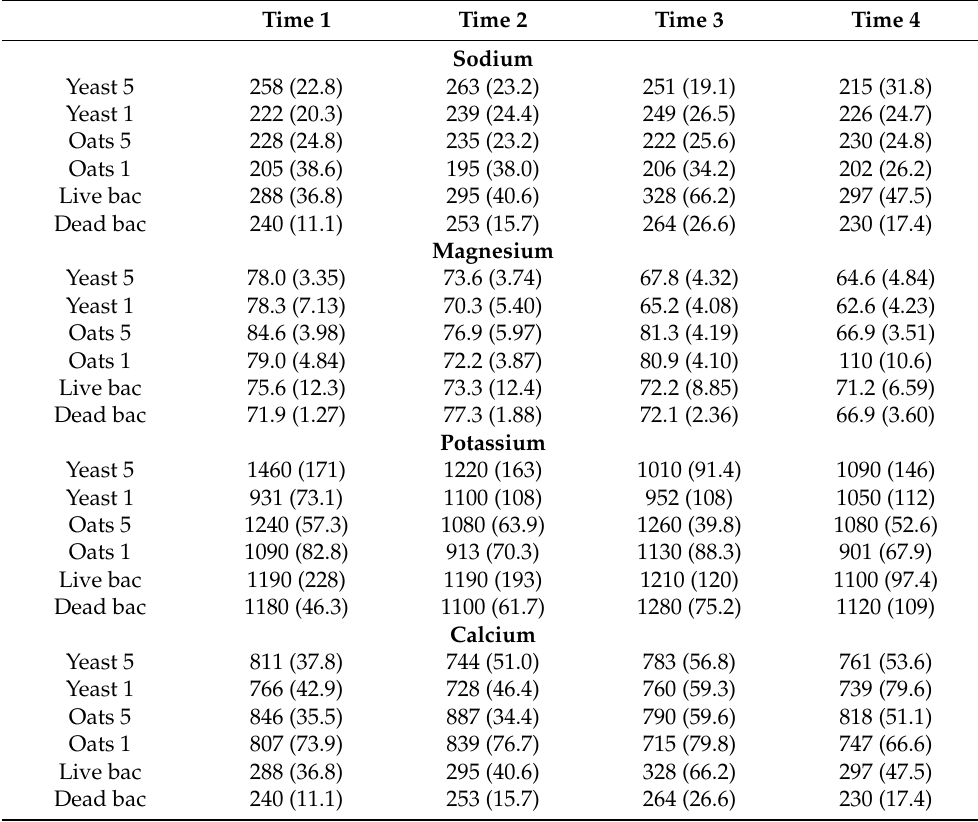
Table 2. Descriptive parameters of minerals by time